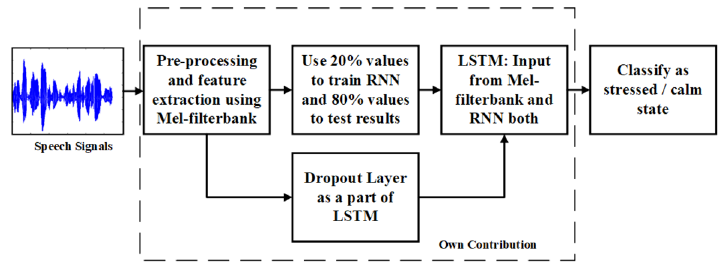
Figure 6. Speech Signals based Human Stress detection.